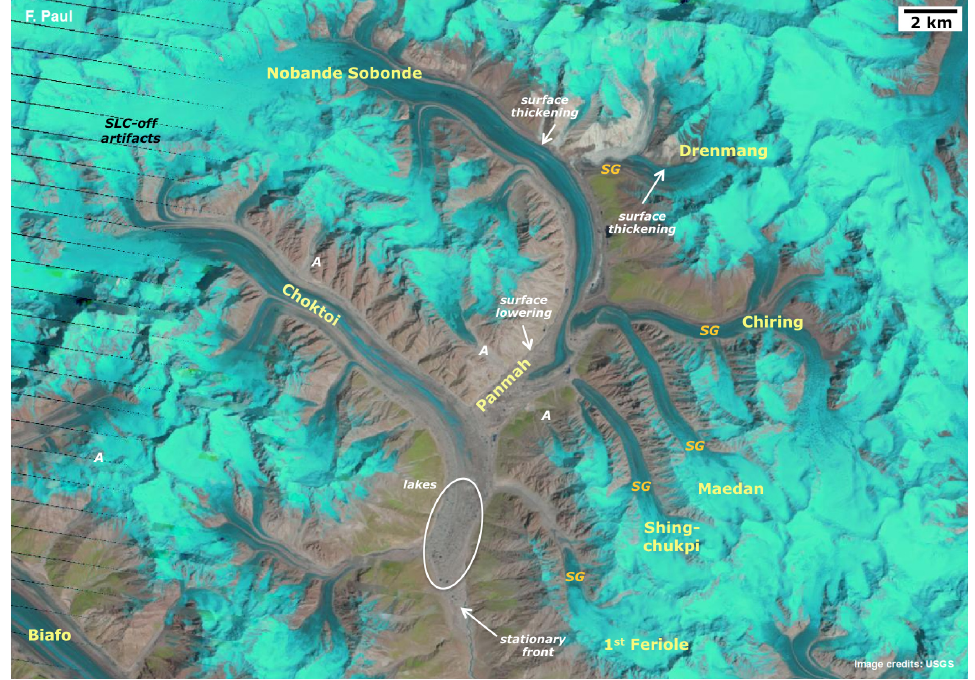
Figure 3. Subregion (2) (Panmah) shows the region around Panmah and Choktoi glaciers with surrounding tributaries; annotations and Landsat scene as in Fig. 2.